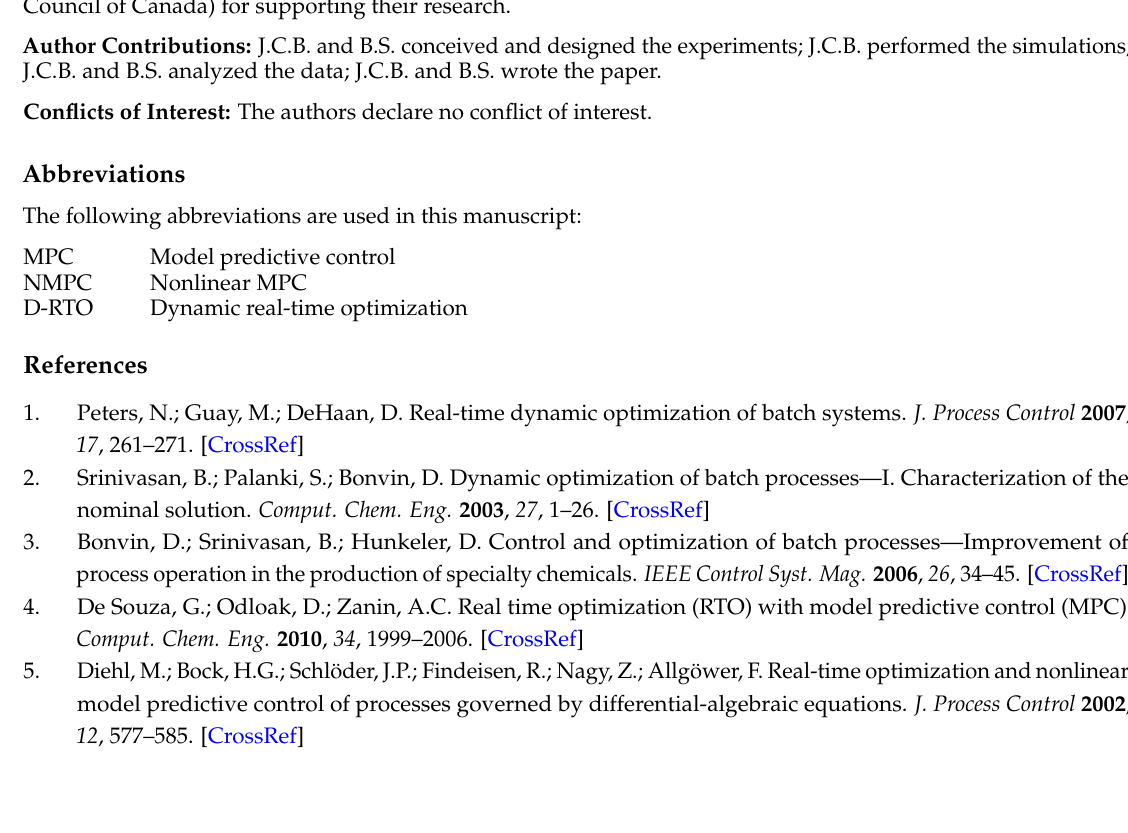
and . Figure 1. Input for Case 1, with perturbation in α and k 1 0 𝑘𝑘� 1 0 𝛼𝛼